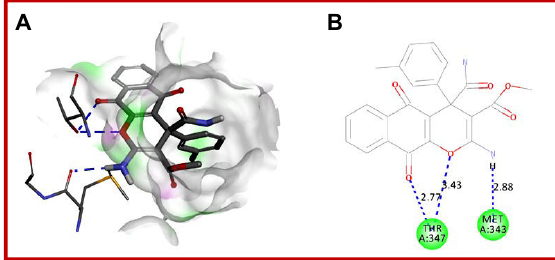
Figure 7: The binding mode between the active conformation of compound 34 and the estrogen receptor α (A) The receptor surface model with compound 34. (B) The 2D diagram of interactions between compound 34 and the estrogen receptor α. The H-bond (blue arrows) is displayed as dashed